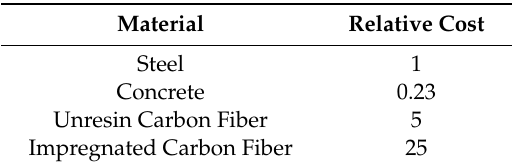
Table 5. Materials relative cost per unit